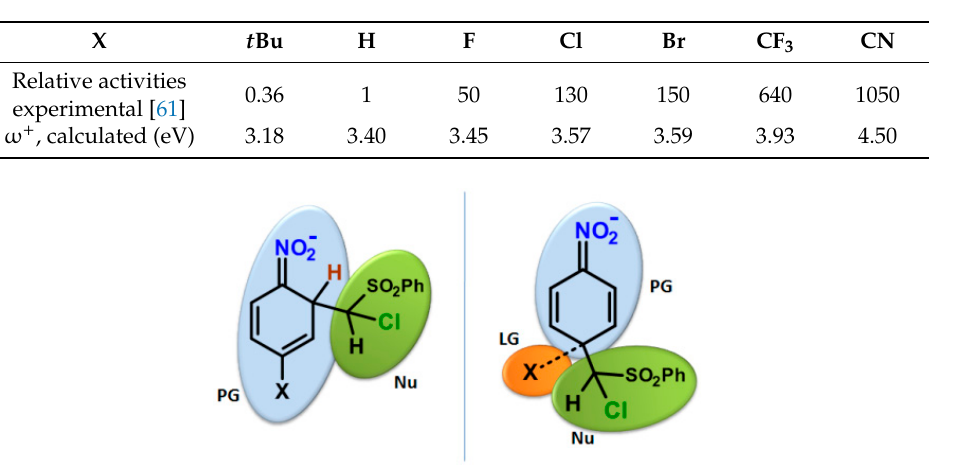
Figure 5. Models of σ H - and σ X -adducts as S N Ar-H and S N Ar-X reaction intermediates with breakdown into PG—permanent group, Nu—nucleophile, and LG—leaving group. Based on conceptual density functional theory [62,63], the electrophilicity and nucleophilicity indices for the addition of the selected nucleophile in the ortho position of nitrobenzene derivatives were calculated, Figure 6.